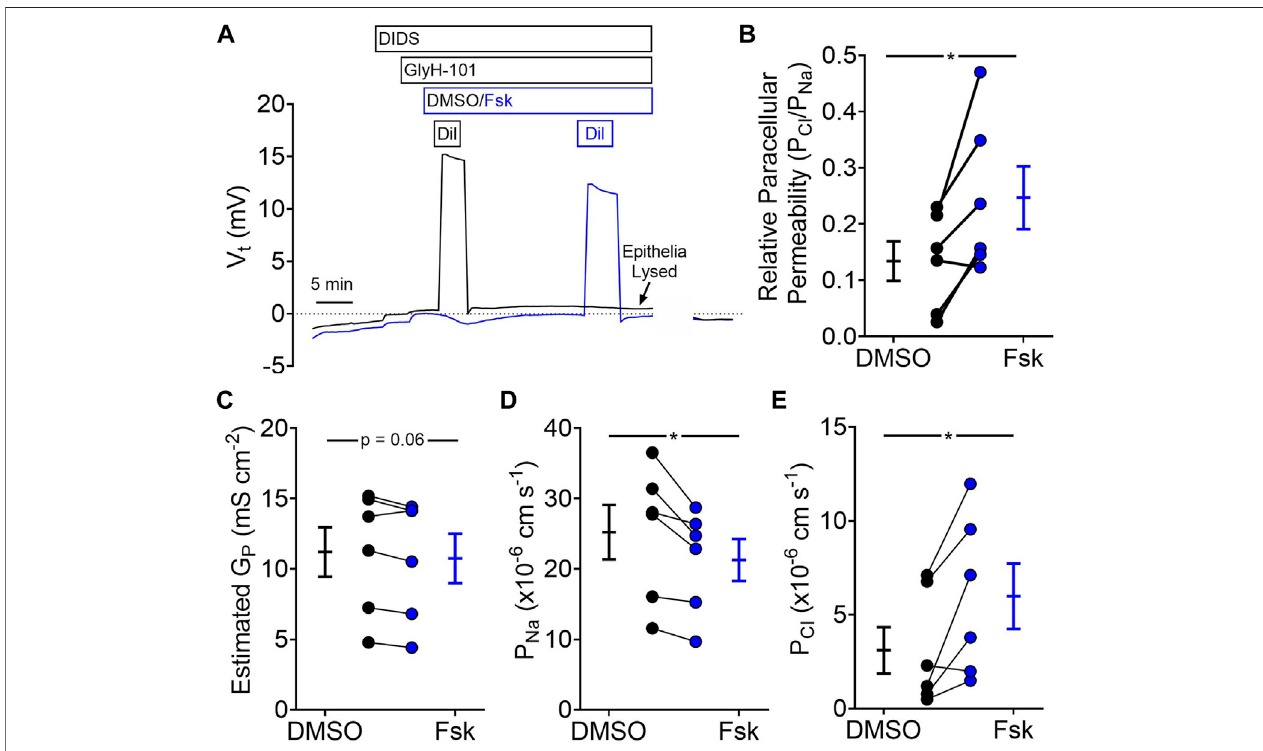
FIGURE 4 | Forskolin increases paracellular permeability of Cl − relative toNa + (A) Representative traces ofvoltage potential from dilution potentialexperiments. (B) Relative paracellular permeability of Cl − relative to Na + after vehicle (DMSO) and forskolin (Fsk) treatment (C) Estimated paracellular conductance. (D) Na + permeability, and (E) Cl − permeability before and after forskolin treatment. Final concentration: Fsk = 10 µM (apical), GlyH-101 = 100 μ M, DIDS = 100 µM. Each symbol represents a different donor. Black = DMSO treated, Blue = Fsk. Lines connecting symbols indicating paired samples from the same donor. Bars indicate mean ± SEM. * indicates p -value < 0.05, paired